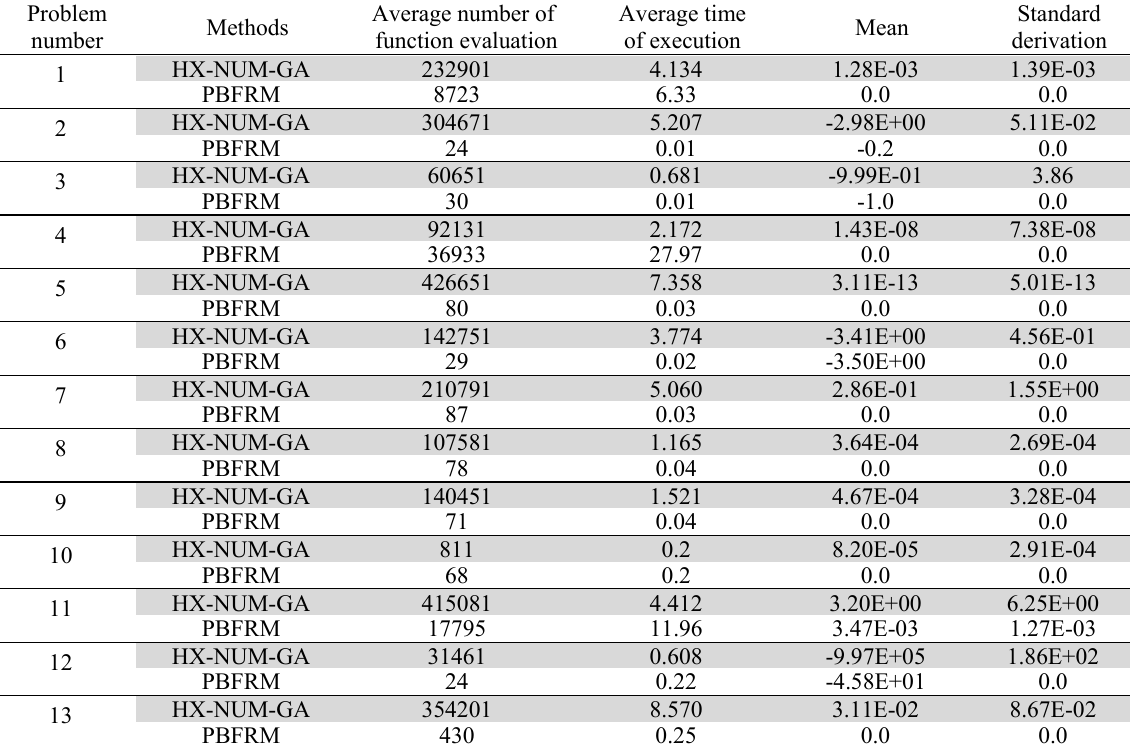
Comparative Study among the methods HX-NUM-GA and PBFRM